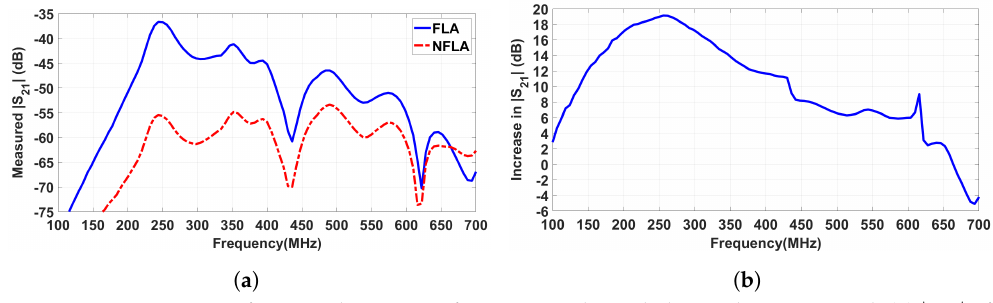
Figure 6. Comparison of FLA and NFLA performance in the scaled grain bin, measured: ( a ) | S 21 | of FLA and NFLA, and ( b ) Increase in | S 21 | for the FLA over the